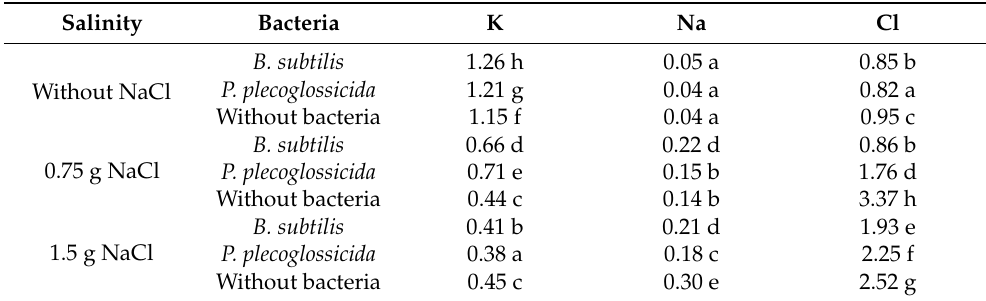
Table 4. Accumulation of saline ions in leaves of Persea americana var. Zutano inoculated with PGPR under salinity stress conditions.